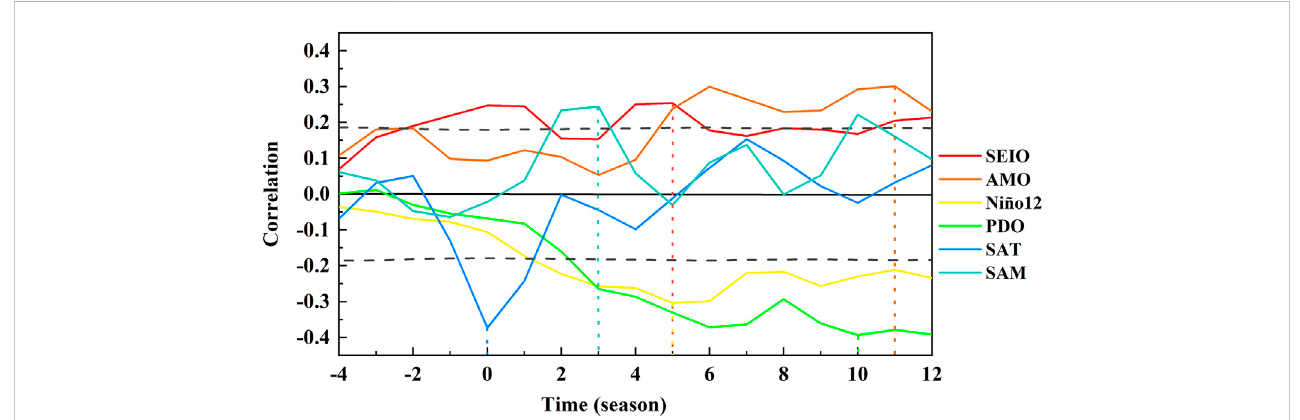
FIGURE 5 Leading – lagged correlation coef fi cients between Weddell Sea SIC and various climate predictors listed on the right of the panel. Positive abscissa value indicates that thepredictor is ahead of Weddell Sea SIC, and negative valueindicates that the factor lags behind Weddell Sea SIC. The maximumcorrelation is identi fi edbyaverticallineofcorrespondingcolor.Theblackdashedlinesdenotecorrelationcoef fi cientspassedthetwo-sided t -testwiththe95%con fi dence level using the effective degrees of freedom.